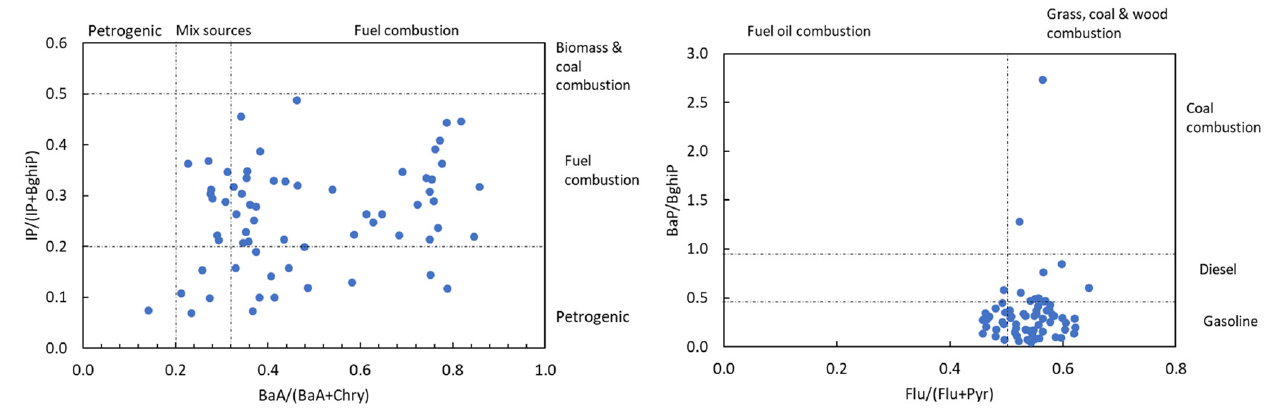
Figure 1. PAH diagnostic ratios for the identification of pollution emission sources in household dust samples from the city of Zagreb.